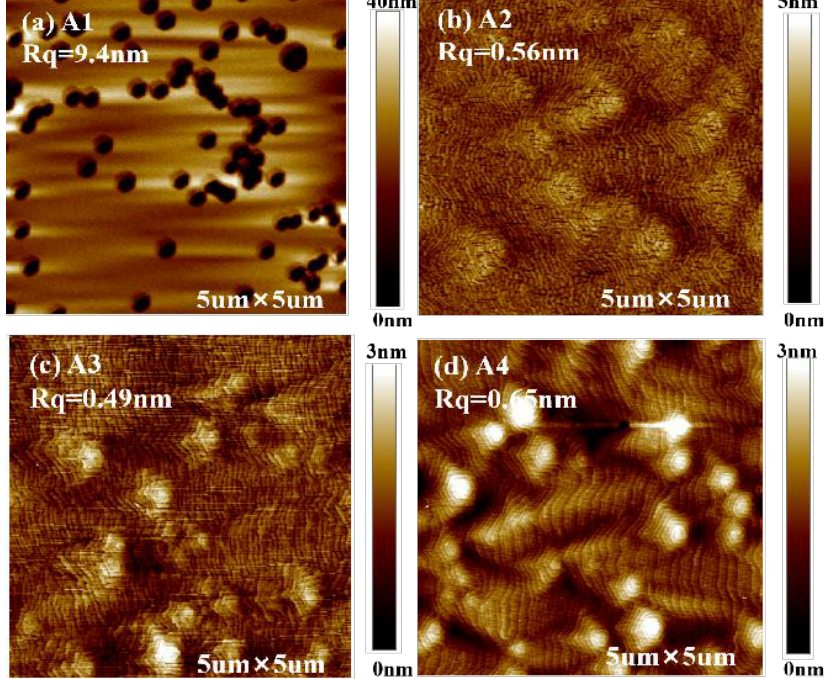
Figure 1. ( a – d ) are, respectively, 5 × 5 µ m AFM images for sample A1, A2, A3 and A4. The corresponding metal source shutter opening time of samples A1, A2, A3, and A4 are 5 s, 10 s, 15 s, 20 s, respectively. The metal source shutter closing time is kept at a constant of 5 s.